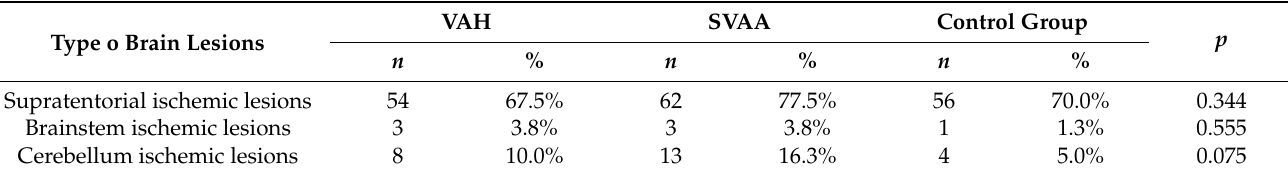
Table 5. Cerebral imaging findings.